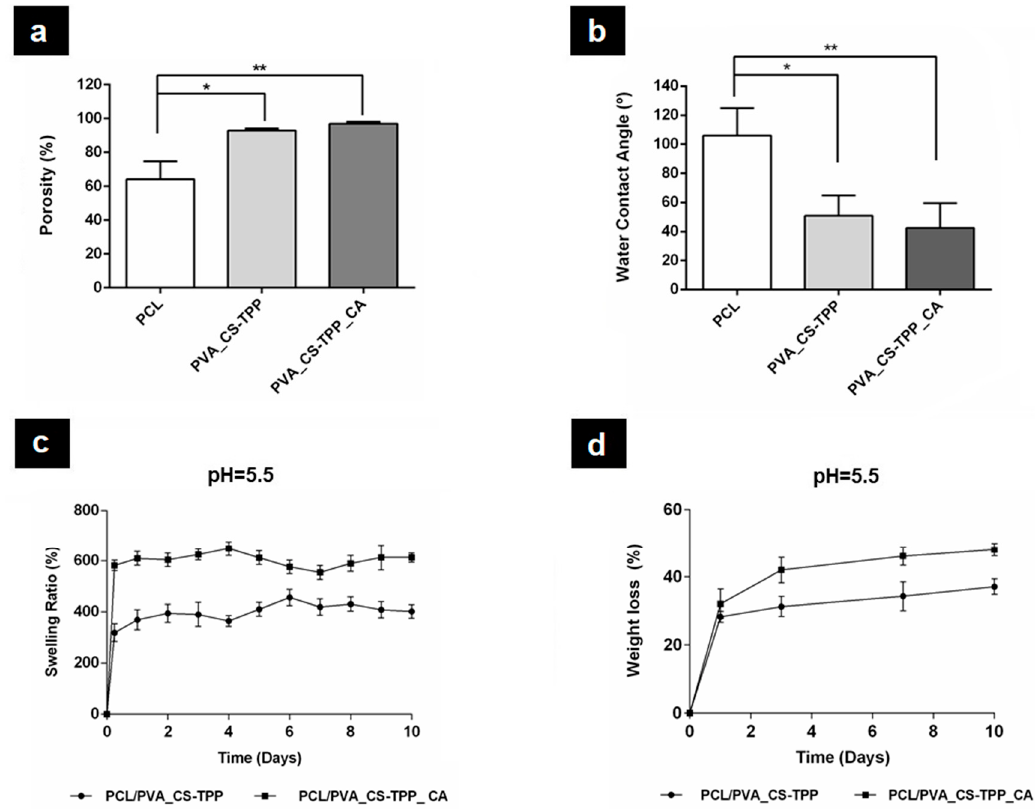
Figure 4. Characterization of the total porosity ( a ); wettability ( b ); swelling profile ( c ); and weight loss at pH = 5.5 ( d ) of the produced double-layered membranes. (Data are represented as average ± standard deviation (S.D.), * p < 0.05 and ** p < 0.001).